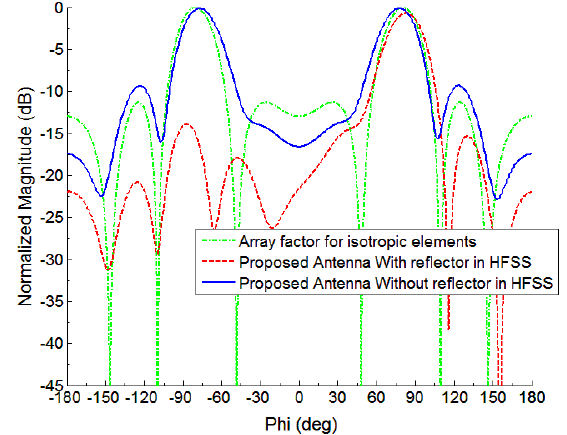
Figure 2. Radiation pattern at f = 3.5 GHz for a linear array having four elements in case of isotropic, actual monopole, and grounded reflector of the proposed frequency scanning fan beam array antenna.